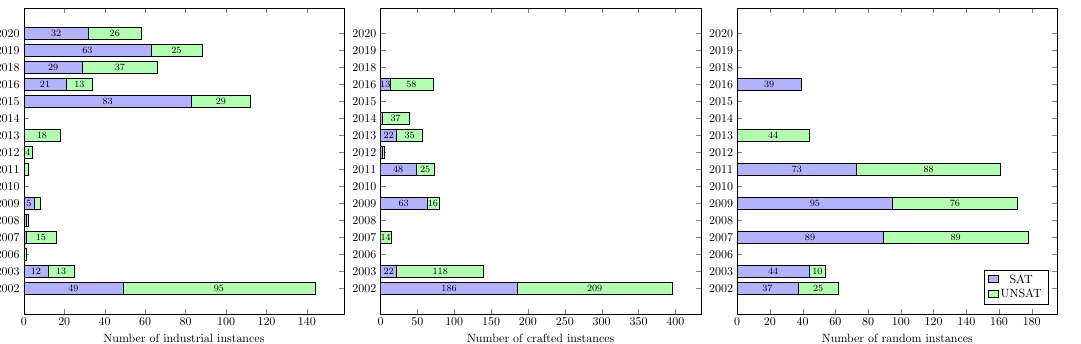
mark instances, the backdoor size and coverage are greater than those in the industrial category. Additionally, across all SAT benchmarks, there tends to be little overlap between backbone and backdoor variables.